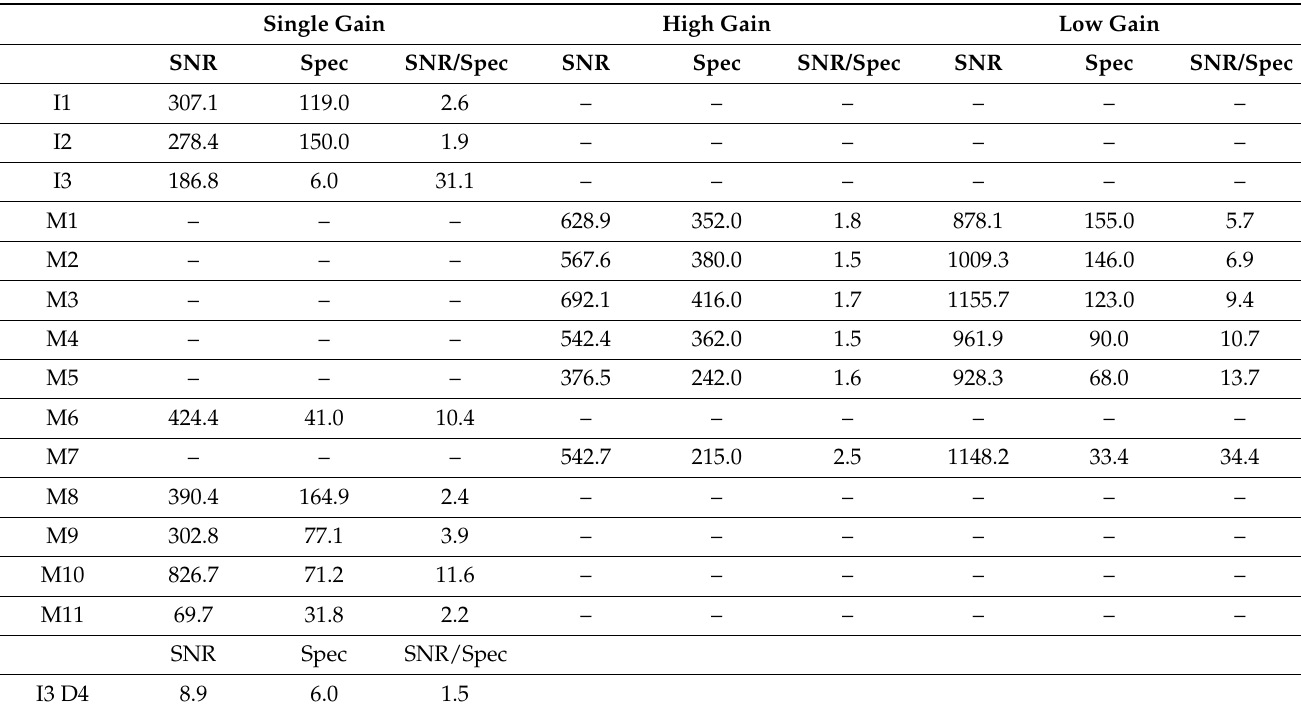
Table 4. Signal-to-noise ratio (SNR) results for the VIIRS reflective solar bands. The SNR, SNR requirement, and ratio of the two are shown here. All bands pass the SNR requirements with out-of-family band I3 detector 4 (shown at the bottom) passing as well. Single Gain High Gain Low